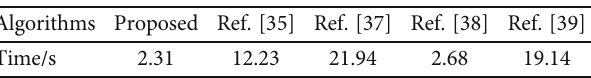
Table 7: Time e ffi ciency